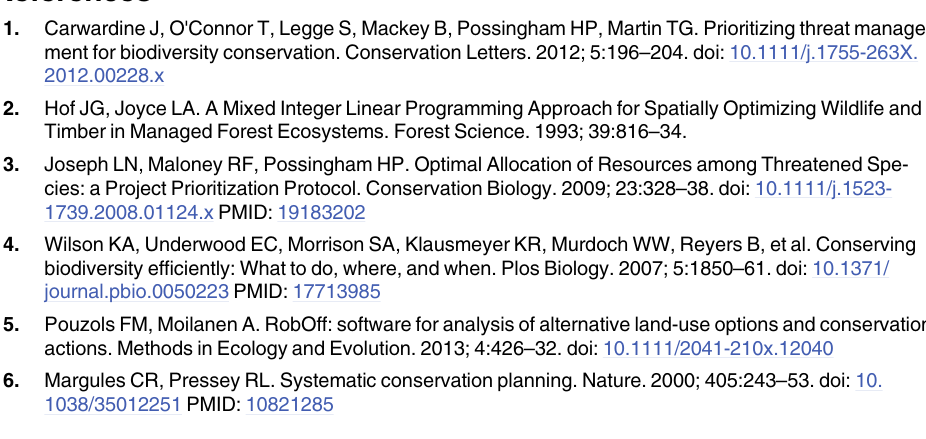
S10 Fig. Selection frequency of different actions for CSM = 0.3. Selection frequency is calcu- lated as the number of times each action is selected across 100 replicates. Actions are: buffalo control ( “ Buffalo ” ), cane toad control ( “ Cane Toad ” ), river flow-regime restoration ( “ Flow ” ), grazing management ( “ Grazing ” ) and land acquisition ( “ Land ” ). S11 Fig. Selection frequency of different actions for CSM = 0.35. Selection frequency is cal- culated as the number of times each action is selected across 100 replicates. Actions are: buffalo control ( “ Buffalo ” ), cane toad control ( “ Cane Toad ” ), river flow-regime restoration ( “ Flow ” ), grazing management ( “ Grazing ” ) and land acquisition ( “ Land ” ). S12 Fig. Selection frequency of different actions for CSM = 0.7. Selection frequency is calcu- lated as the number of times each action is selected across 100 replicates. Actions are: buffalo control ( “ Buffalo ” ), cane toad control ( “ Cane Toad ” ), river flow-regime restoration ( “ Flow ” ), grazing management ( “ Grazing ” ) and land acquisition ( “ Land ” ). S13 Fig. Selection frequency of different actions for CSM = 0.4. Selection frequency is calcu- lated as the number of times each action is selected across 100 replicates. Actions are: buffalo control ( “ Buffalo ” ), cane toad control ( “ Cane Toad ” ), river flow-regime restoration ( “ Flow ” ), grazing management ( “ Grazing ” ) and land acquisition ( “ Land ” ). S1 Table. Values of the simulated annealing parameters used in the action prioritization al- gorithm.